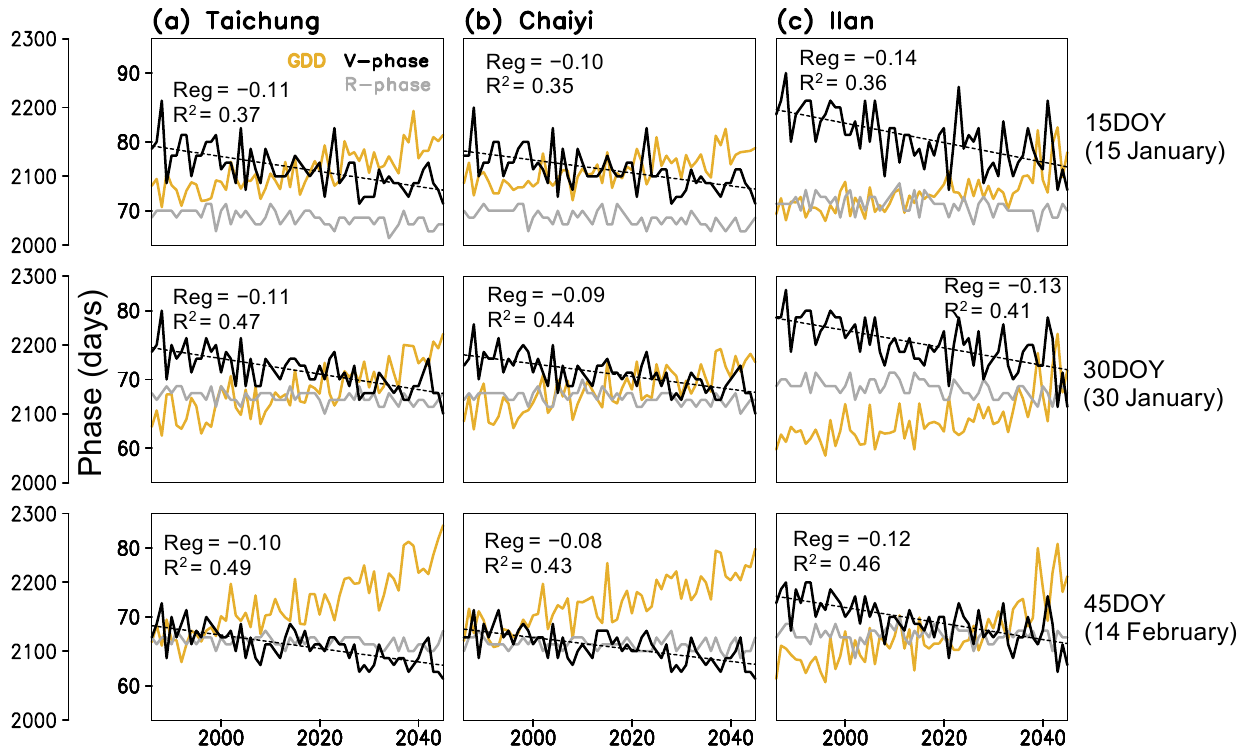
Figure 5. Time series of simulated growing degree days (GDD), lengths of vegetative (V ‐ phase) and reproductive (R ‐ phase) stages for three planting dates (15, 30, 45 day of year) constructed for ( a ) Taichung, ( b ) Chaiyi, and ( c ) Ilan; linear regression coefficients (Reg) and coefficient of determination (R 2 ) between year and V ‐ phase present in each panel.